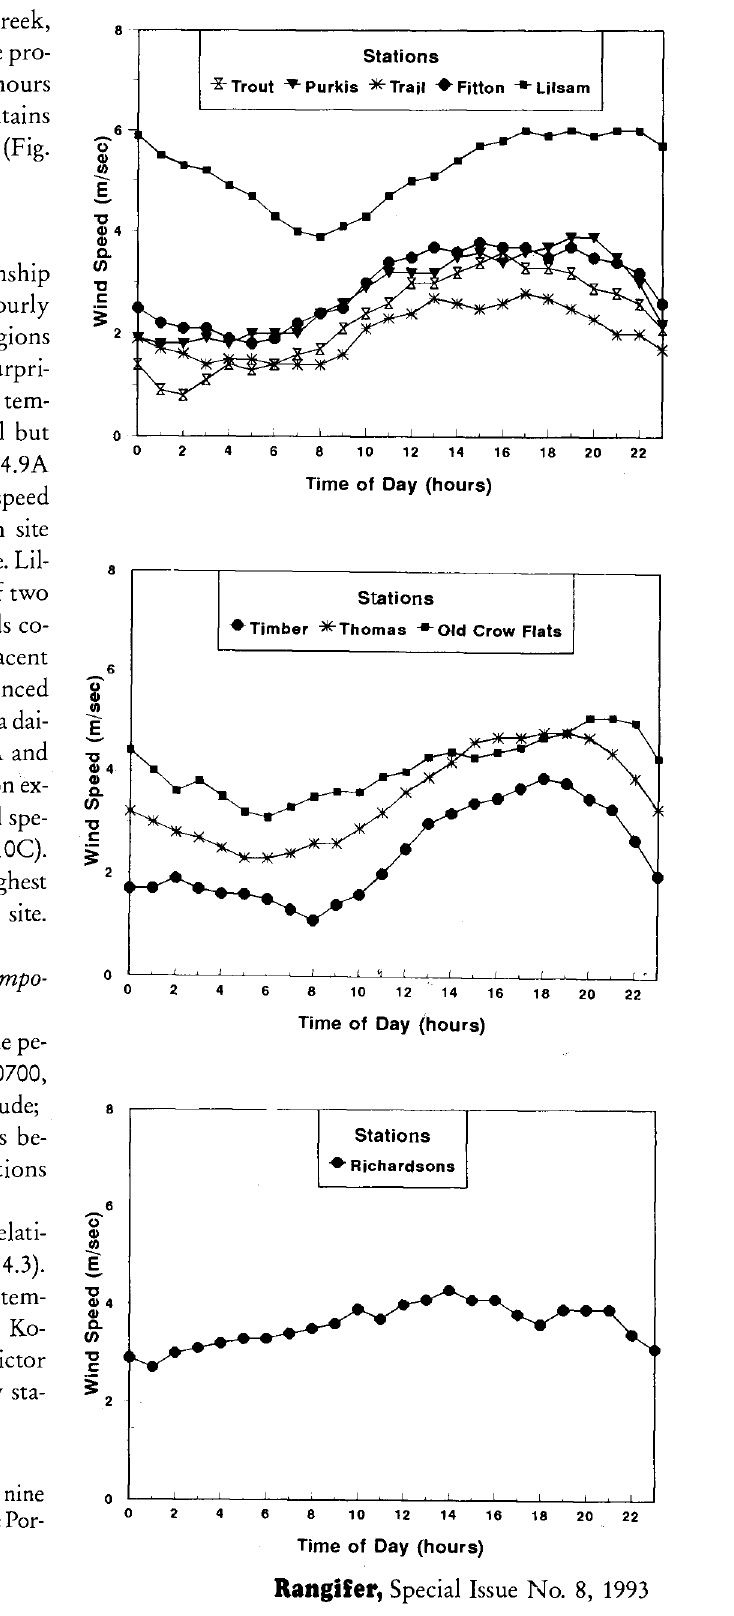
Figure 4.10. Average hourly windspeeds at nine sites on the summer range of the Por cupine Caribou Herd,